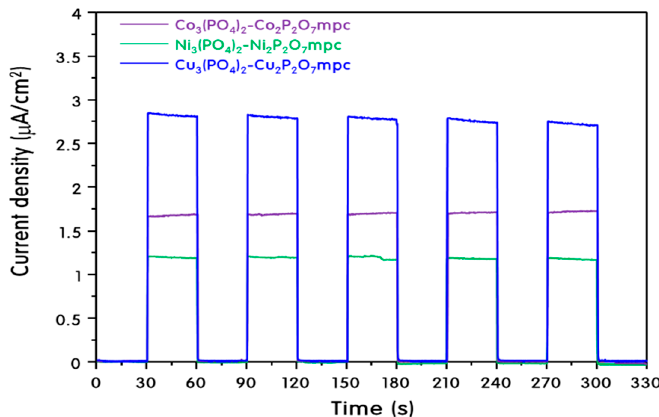
Figure 6. Photocurrent responses of the M 3 (PO 4 ) 2 -M 2 P 2 O 7 mpc (M = Co, Ni, and Cu).